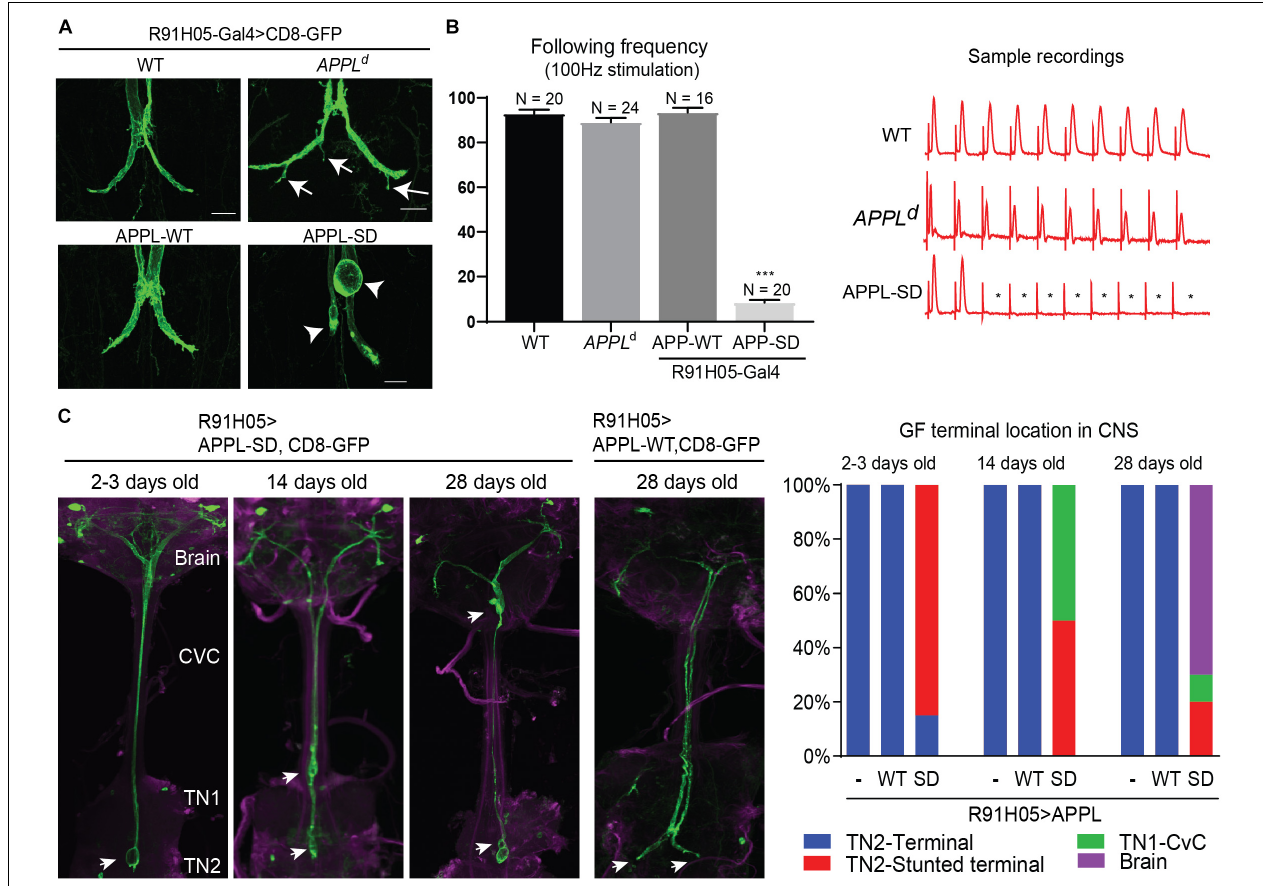
FIGURE 4 | Morphological GF terminal phenotypes in APPL gain and loss of function mutants. (A) GF terminal morphology of controls (WT), APPL d null mutants and animals overexpressing wildtype (APPL-WT) and secretion-deficient (APPL-SD) APPL throughout GF development. Terminal pruning defects are labeled by arrows. Stunted terminals or GFs with retraction bulbs are labeled by arrowheads. Scale bars represent 20 µ m. (B) Functional defects of controls (WT), APPL d null mutants and animals overexpressing wildtype (APPL-WT) and secretive defective (APPL-SD) APP with the R91H05 Gal4-line. The function of GF to TTMn synapse was determined by quantifying the average number of responses from 10 trains of 10 GF stimulations given at 100 Hz. Quantification is shown in the graph on the left. N indicates numbers of GF-TTMn connections assessed per genotype. Error bars represents standard error mean. Statistical significance between genotypes was assessed using Student’s t -test ( ∗∗∗ p < 0.001). Samples traces of electrophysiological recordings of one train are shown on the right. ∗ mark absent responses. (C) GF terminal localization in young and aged animals overexpressing wildtype (APPL-WT) and secretion-deficient (APPL-SD) APP. GFs were labeled by co-expression of CD8-GFP. In the left panels the GF terminal localization in the target area (TN2, second thoracic neuromere), first thoracic neuromere (TN1), cervical connective (CvC) or the brain are indicated by arrows. Quantification of GF terminal localization in young and aged animals are shown in the right graphs. Ten or more GFs were assessed for each genotype and time